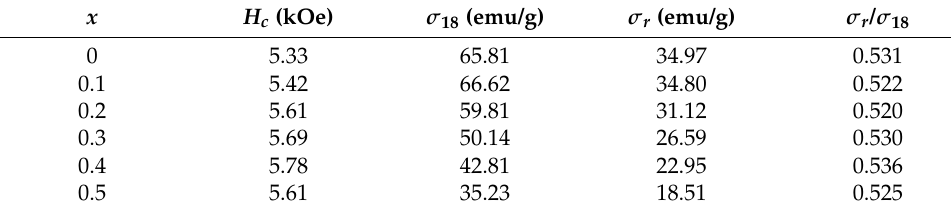
Table 4. Magnetic hysteresis properties of SrFe 12-x Nd x O 19 (0 ≤ x ≤ 0.5) powders.